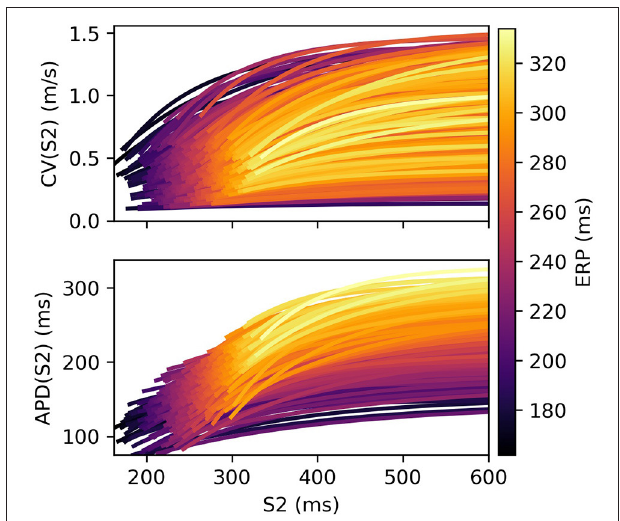
FIGURE 1 | S2 restitution curves for S1: 600 ms for CV(S2) and APD(S2), colored by ERP(S1: 600), and plotted only for S2 > ERP(S1: 600) for